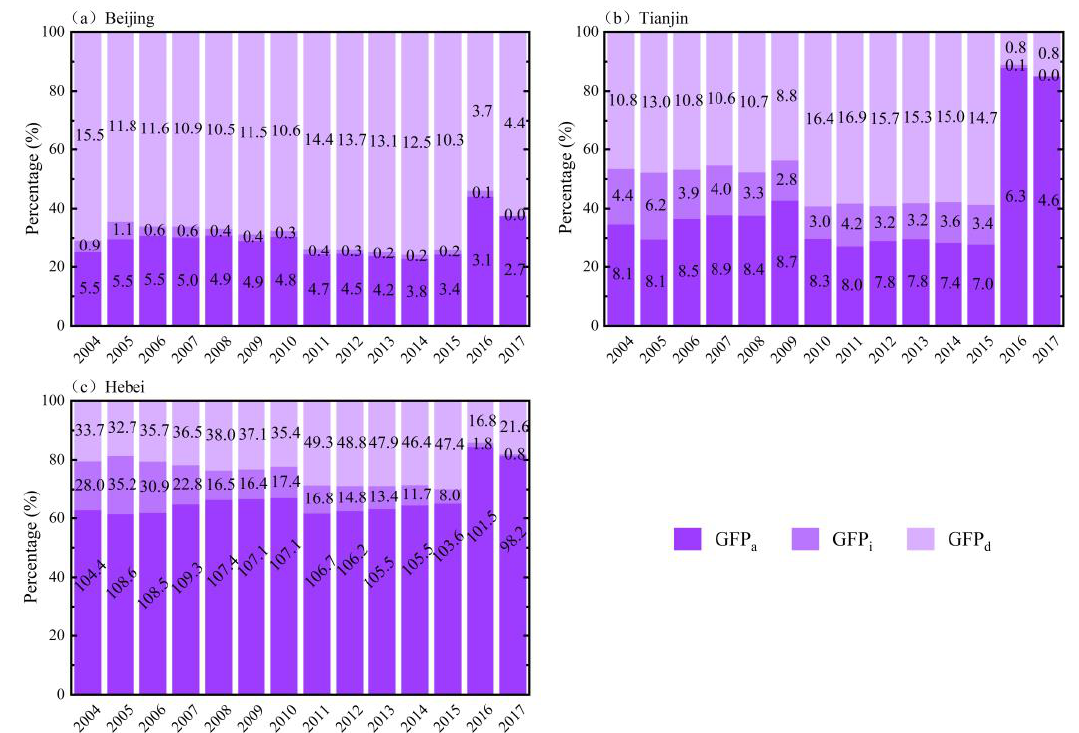
Figure 7. The proportion of GWF (with each component ’s amount numbered in black font) in the BTH region.